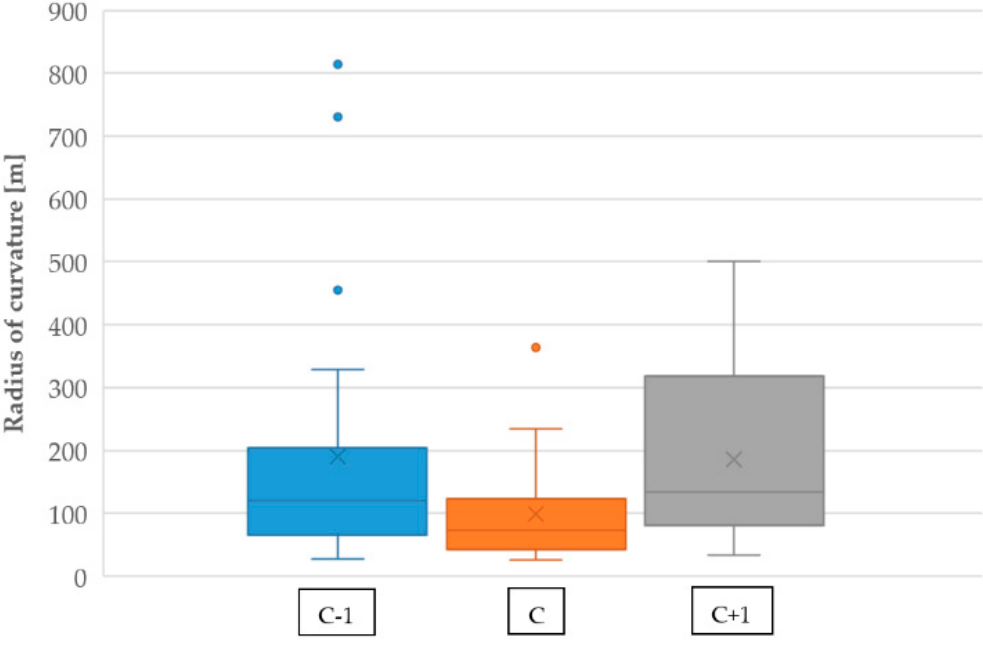
Figure 3. Boxplots of the distribution of the radius of curvature values for the three types of curves (previous C-1, crash C, and following C+1 curves).